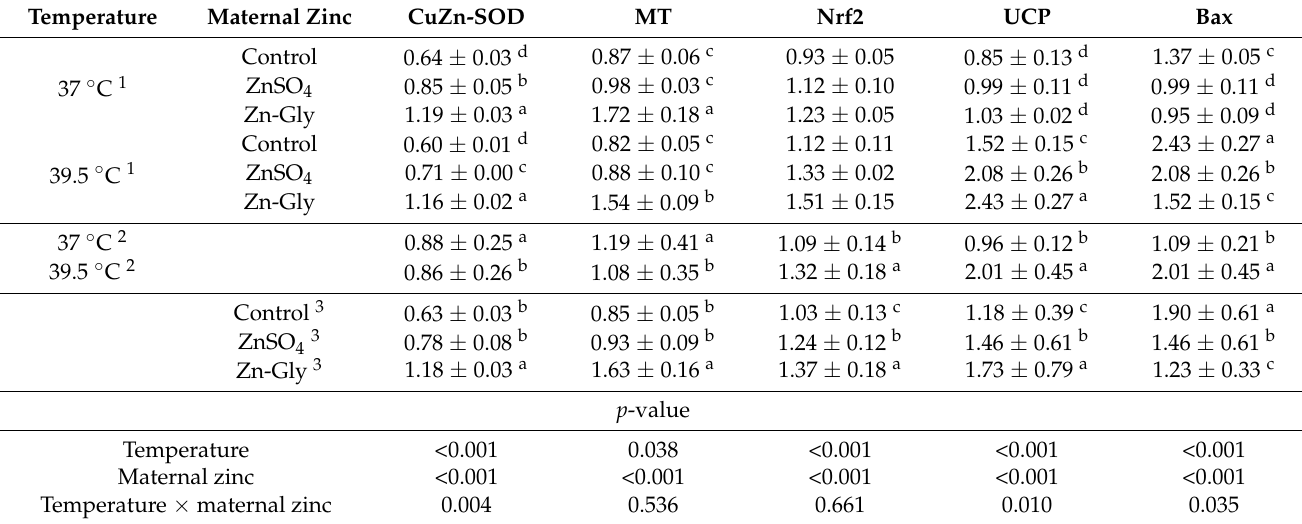
Table 7. Effect of maternal zinc on CuZn-SOD, MT, Nrf2, UCP and Bax mRNA abundance expression in embryos liver under heat stress (mean ±